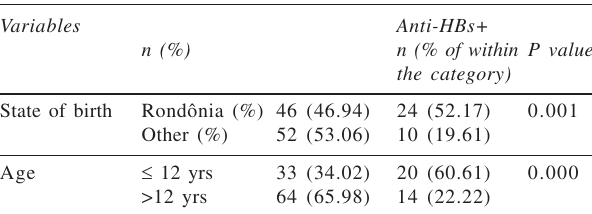
Table 6 - Anti-HBs positive seromarker in anti-HBc negative subjects.